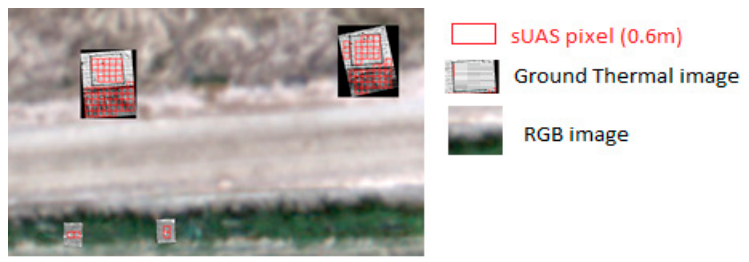
( c ) Figure 7. An example of ground temperature samples taken using the temperature camera mounted on a tripod (3 m height) and connected to a laptop loaded with ICI software IR FLASH on 3 May 2016, at Landsat overpass time. Temperature images of the top of vine canopy ( a ) and bare soil ( b ). Temperature camera and tripod mounted over a truck for fast ground temperature sampling ( c ). 3.3. After Flight Ground and sUAS Pixel Extraction: After each flight, sUAS temperature maps were developed using data from the sUAS onboard inertial measurement unit (IMU) and GPS receiver. This provided the sUAS location (x, y, z coordinates) and orientation (pitch, roll, yaw) to the Agisoft Photoscan